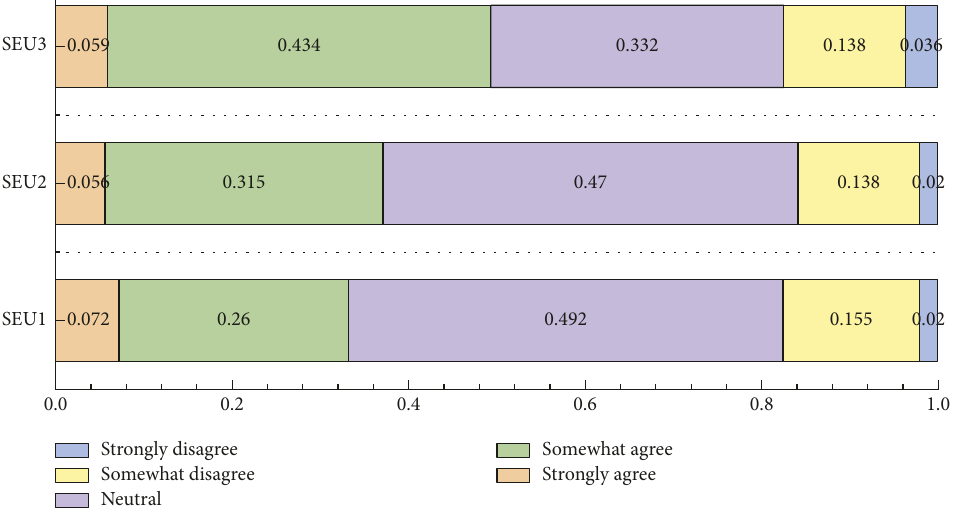
Figure 7: Sense of use